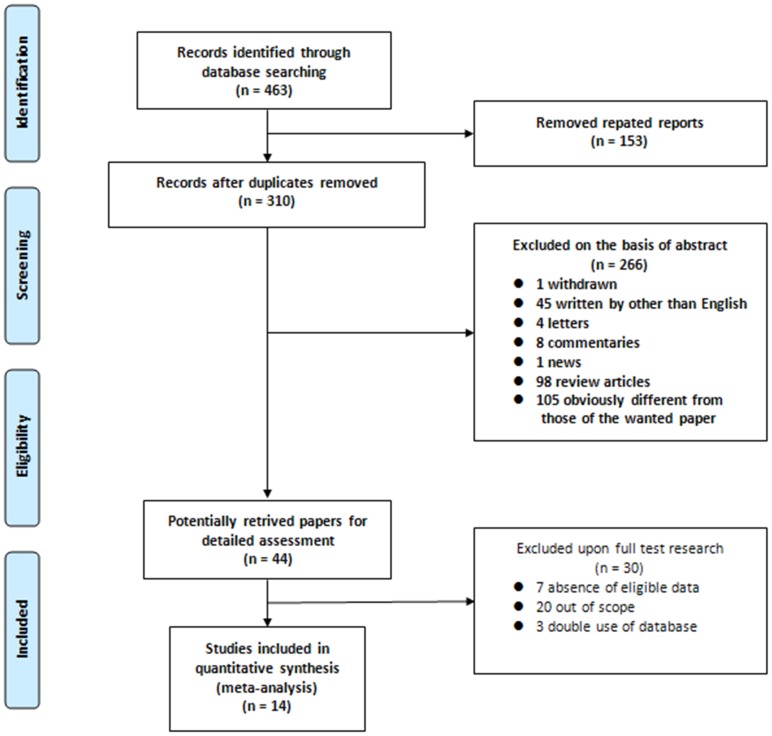
Methodological flow chart of the systematic review.